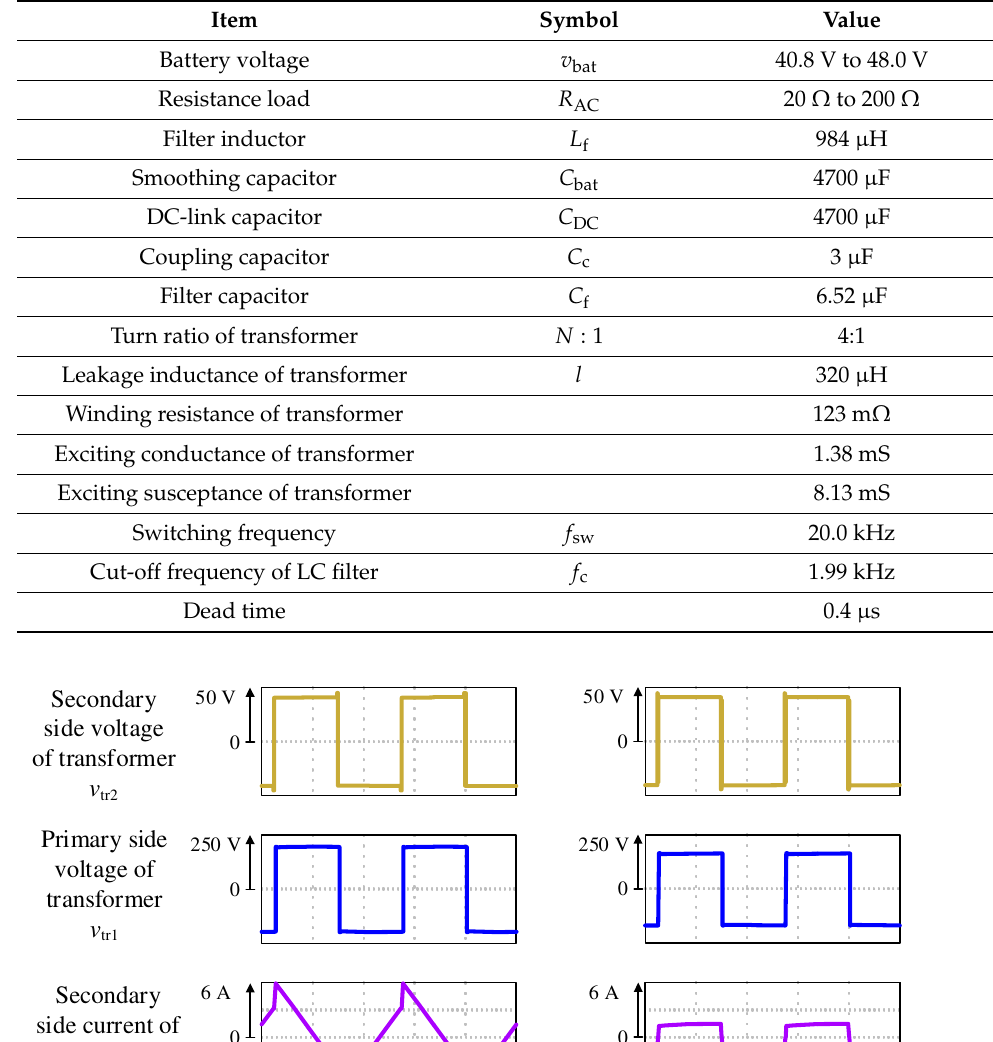
Table 2. circuit constants shown in Figure 8.